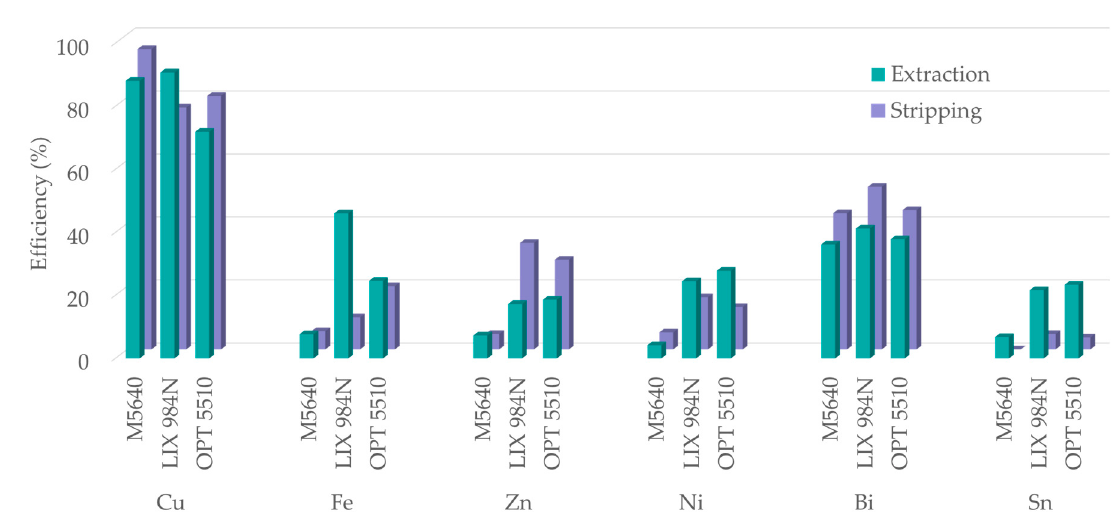
Figure 12. Comparison of extraction (for extractant concentration 20 vol.%, feed pH 1.5, O/A = 3, contact time 10 min) and stripping (H 2 SO 4 180 g/L, O/A = 2, contact time 5 min) efficiency of the three studied extractants (one stage SX conducted at 20 °C).